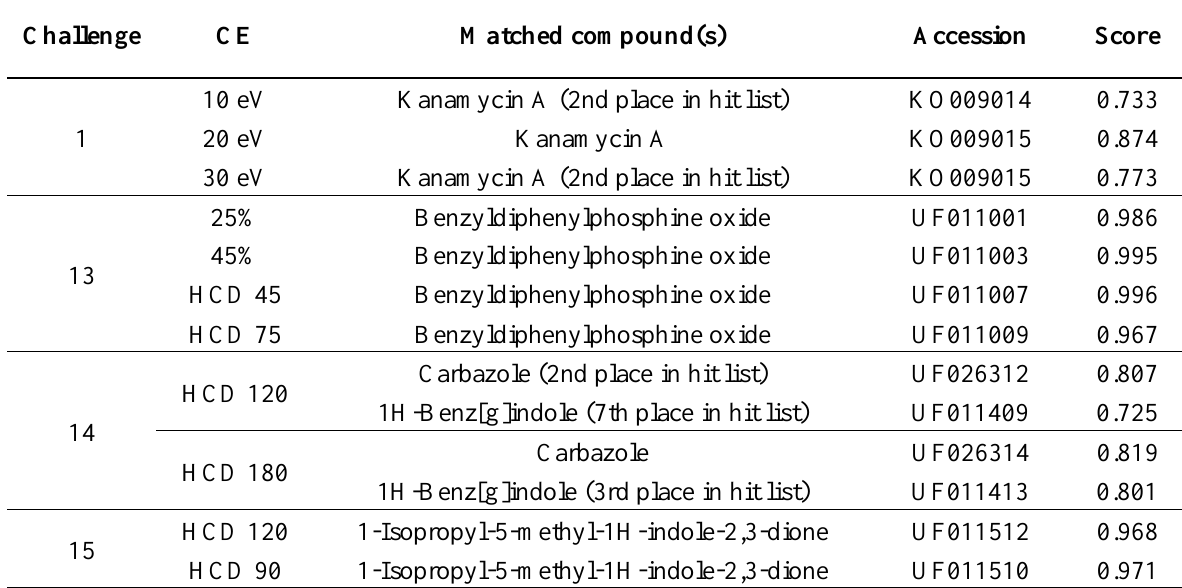
Table 2. Putative identifications with MassBank. Unless otherwise stated, information on the best matching compound only is provided.